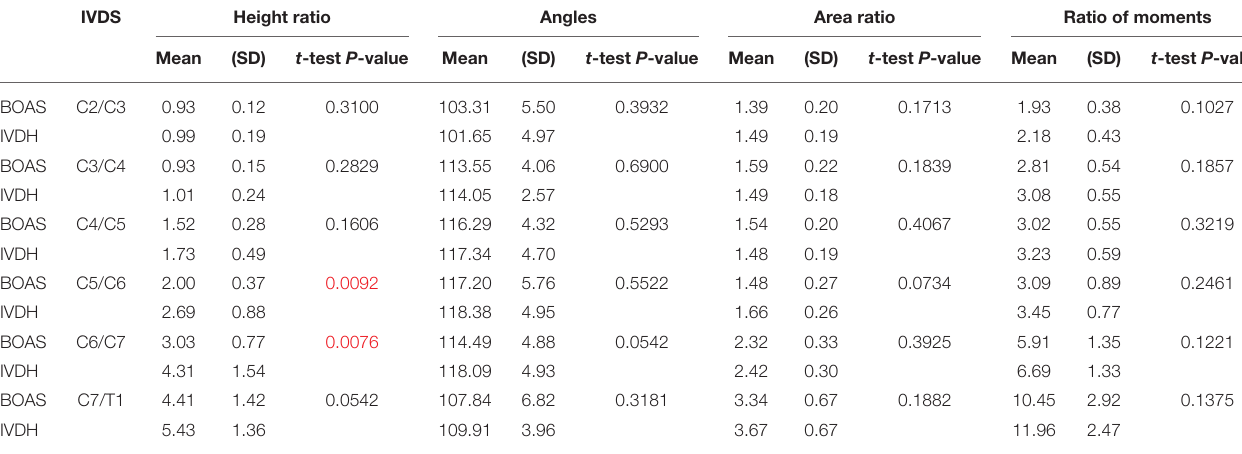
TABLE 2 | Comparison of height ratio, angles, area ratio, and ratio of moments of the different intervertebral disk spaces from C2/C3 to C7/T1 in French bulldogs of the IVDH and BOAS group.